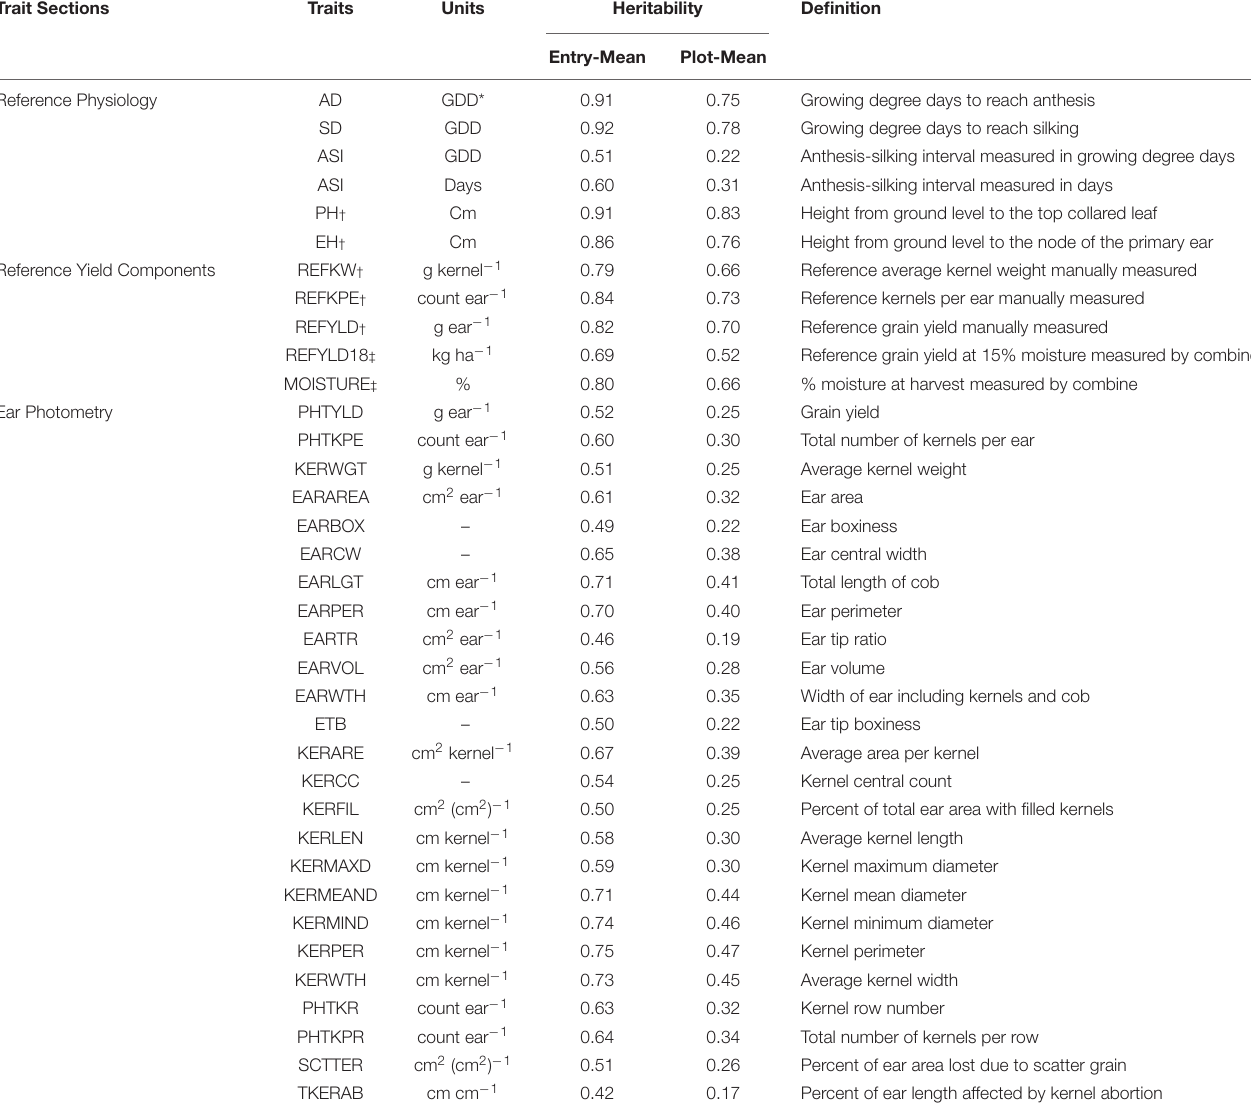
TABLE 1 | Description of the phenotypes evaluated in this study. Trait